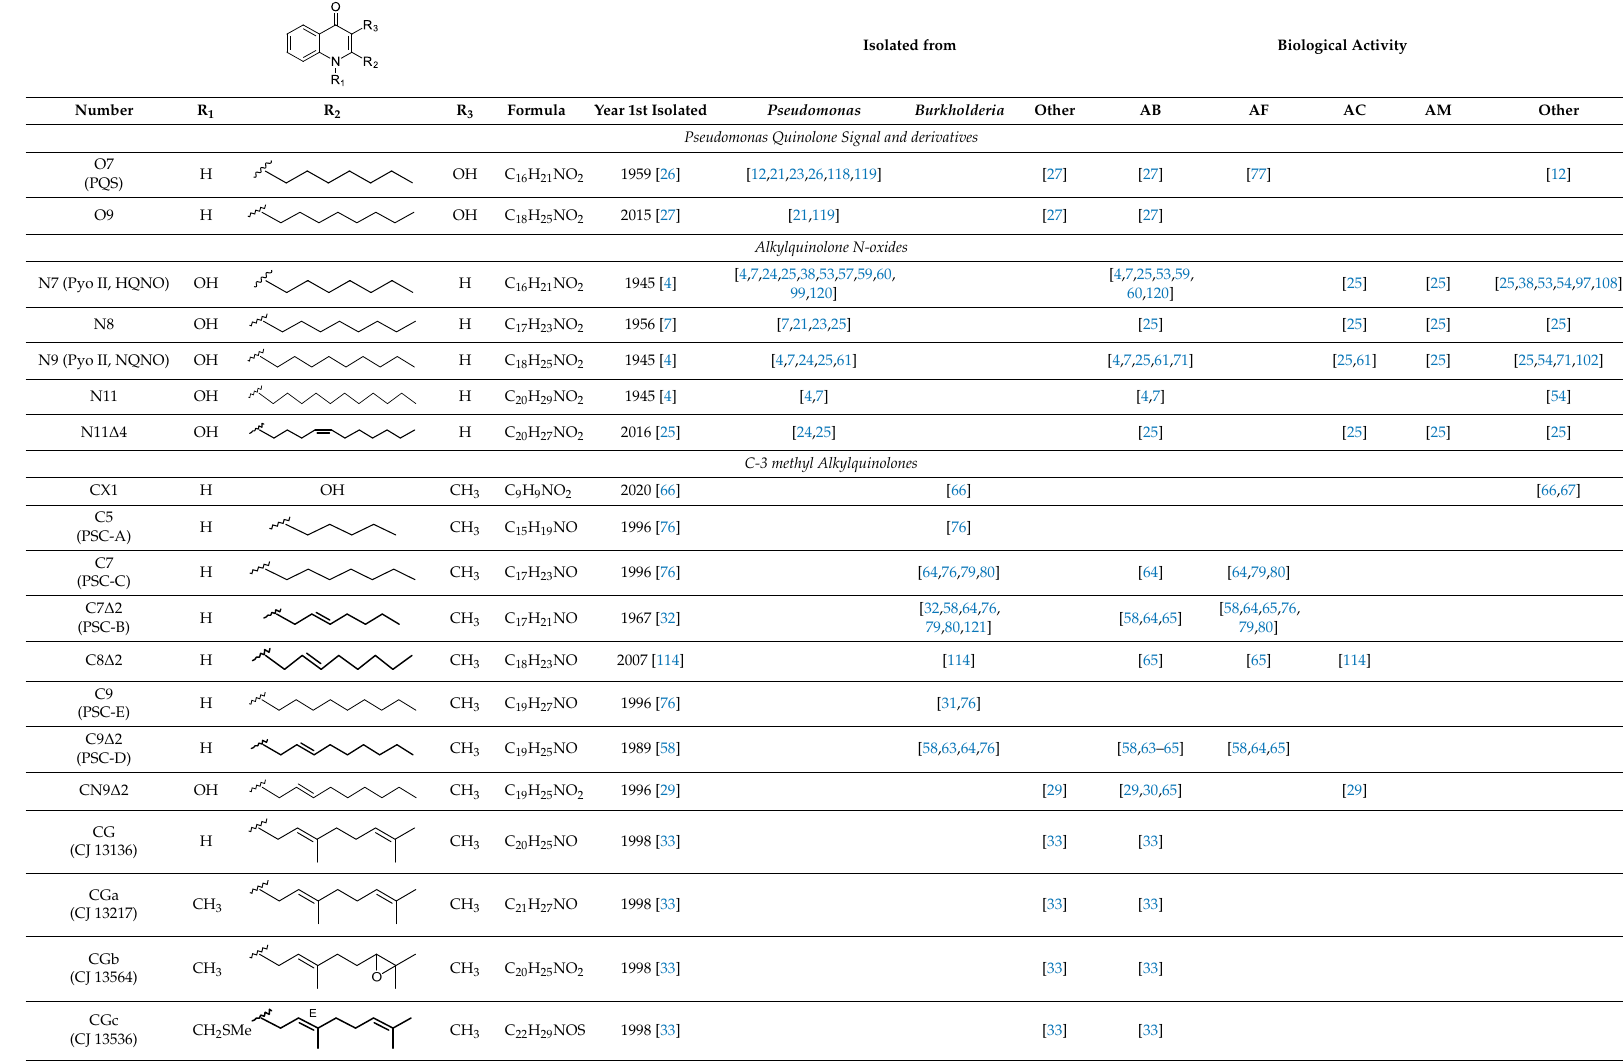
Table A1. Cont. Table A1. Alkyl-4-quinolones isolated from